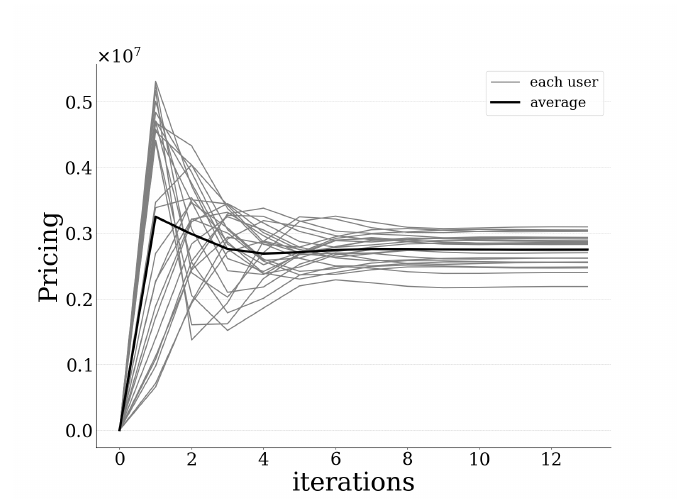
Figure 5. Pricing imposed by the server on each user vs.